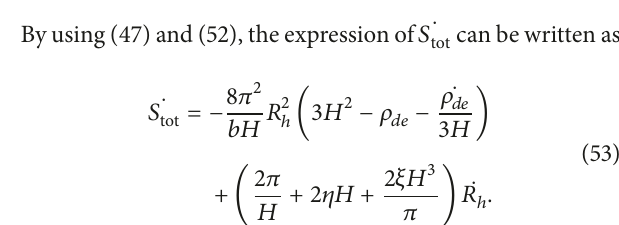
Figure 10: Plot of 𝑋 = at event